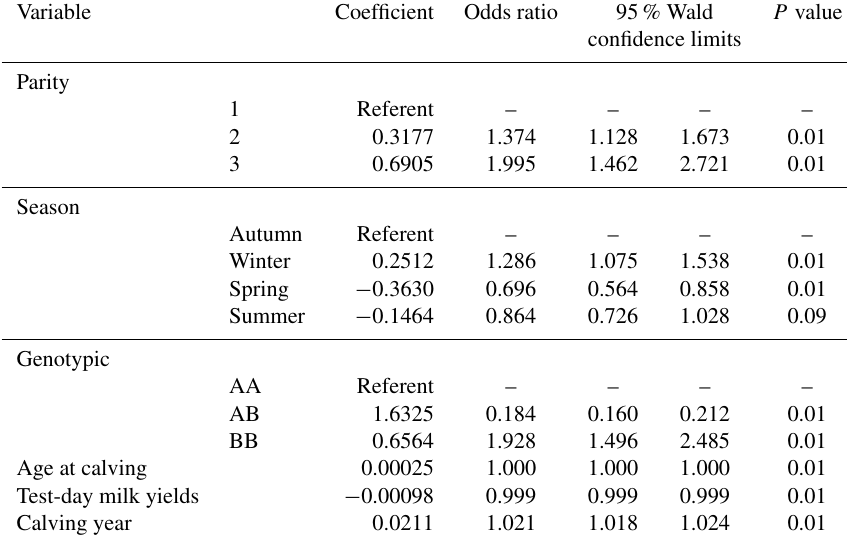
Table 2. Analysis of maximum likelihood estimates and odds ratio